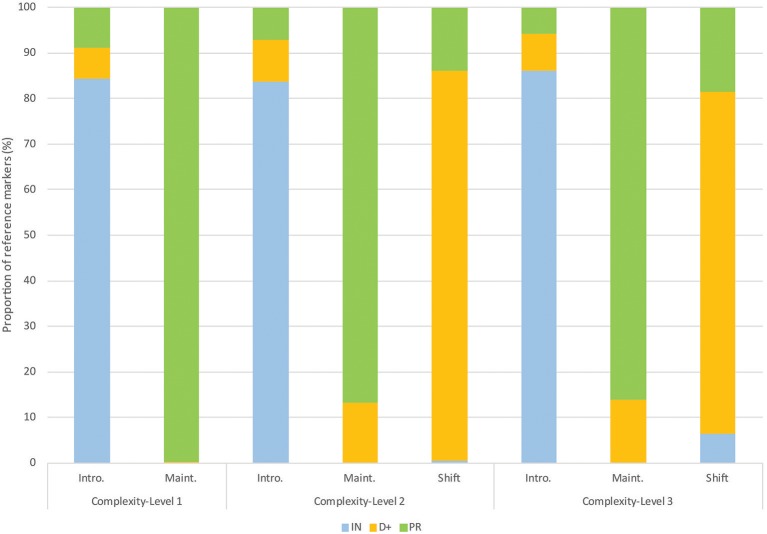
Proportion of each category of reference markers used for each discourse stage and each level of referential complexity-level of the stories. Each type of reference marker is presented with a distinct color.